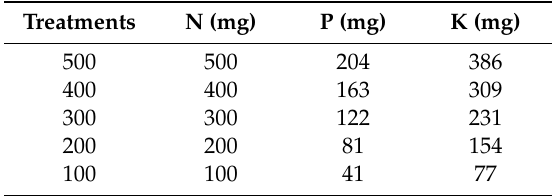
Table 1. Nutrient composition for the five nutrient treatments. Treatments N (mg) P